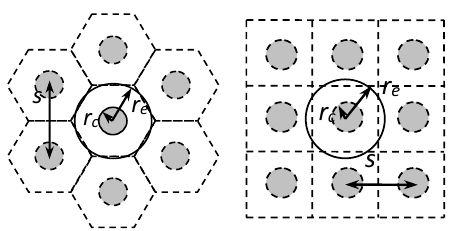
Figure 2. Simplification of the unit cell to axial symmetry conditions.